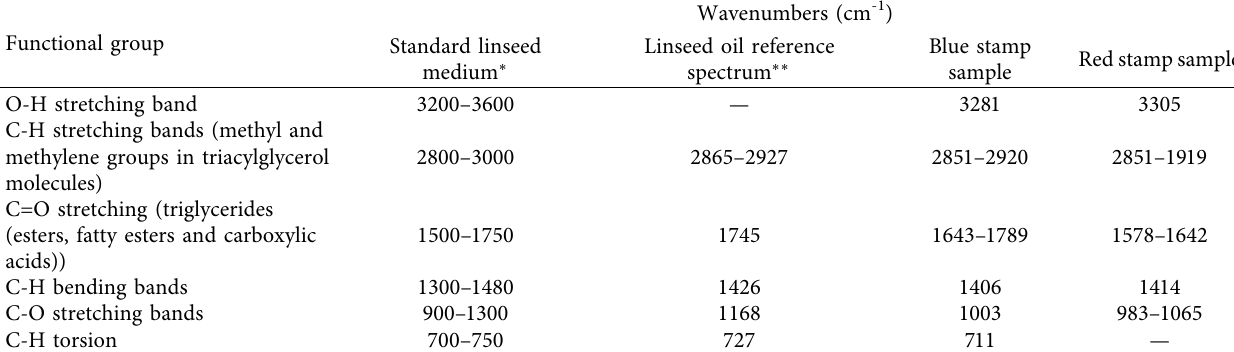
Table 4: Similar functional groups to the FTIR spectrum of the blue and red stamps in linseed oil medium